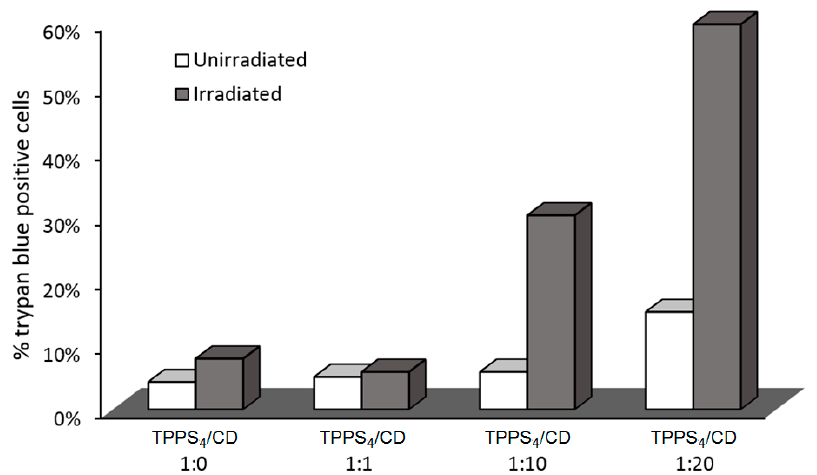
Figure 36. Cell death percentage in HeLa through trypan blue assay. HeLa cells treated with TPPS 4 alone as a control, and with TPPS 4 /SC 6 - β -CD-NH 2 nanoassemblies at 1:2, 1:10, and 1:20 molar ratios, respectively before and after exposition to visible light irradiation for 30 min. Adapted from Sortino; Mazzaglia; Scolaro; Merlo; Valveri; Sciortino [164].